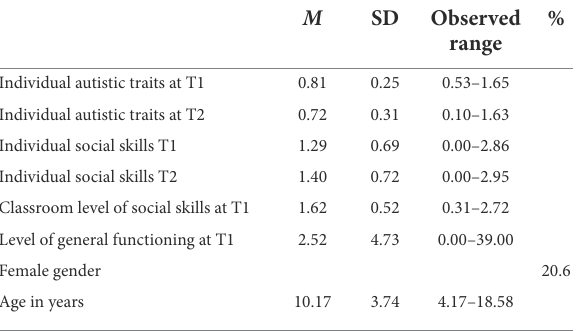
TABLE 1 Descriptive results of the main study variables ( N total =